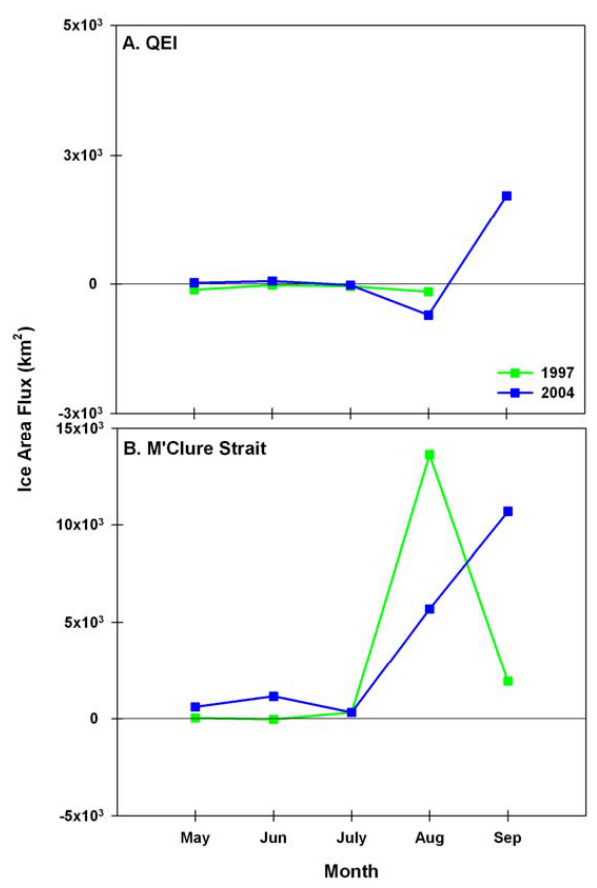
Figure 13. Time series of mean May to September Arctic Ocean-Canadian Arctic Archipelago Fig. 13. Time series of mean May to September Arctic Ocean– sea ice area flux (km 2 ) at the Queen Elizabeth Islands (QEI) (A) and the M’Clure Strait (B) for Canadian Arctic Archipelago sea ice area flux (km 2 ) at the Queen 1997 and 2004 estimated from RADARSAT. No RADARSAT data was available in September Elizabeth Islands (QEI) (A) and the M’Clure Strait (B) for 1997 1997 at the QEI. Positive/negative sign indicates Arctic Ocean inflow/outflow. and 2004, estimated from RADARSAT. No RADARSAT data were available in September 1997 at the QEI. Positive/negative sign indi- cates Arctic Ocean